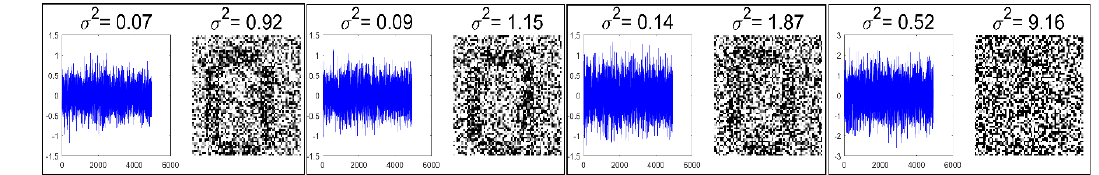
Figure 6. Examples of pairs of noisy auditory and visual representations of the digit 0.